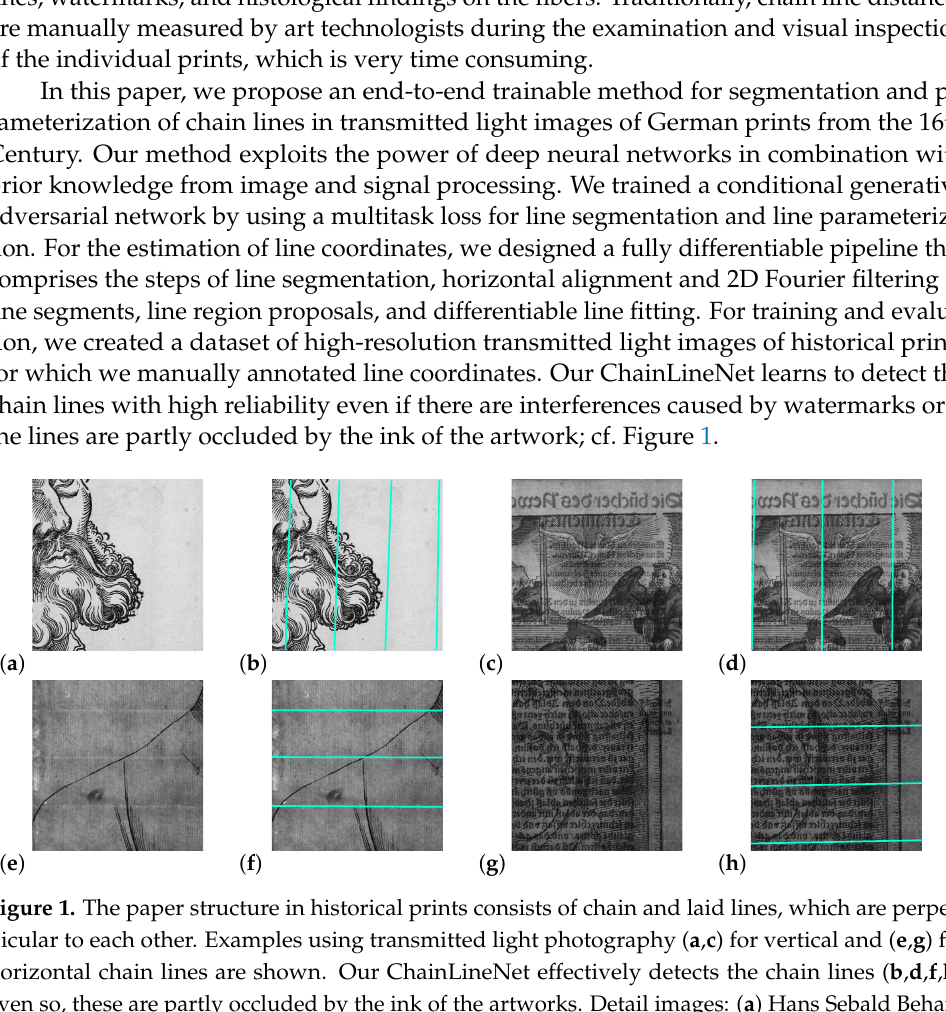
by the respective